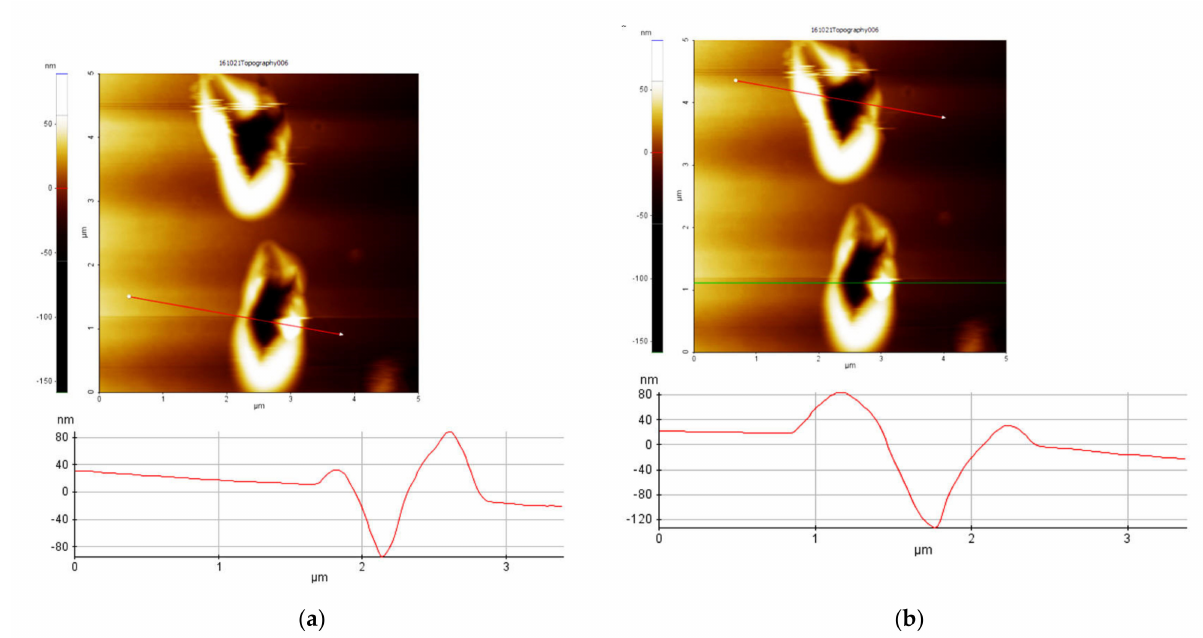
Figure 3. Nanoindentation depths of SU-8 hard baked at 125 ◦ C, tested at 20 ◦ C ( a ) and 100 ◦ C ( b